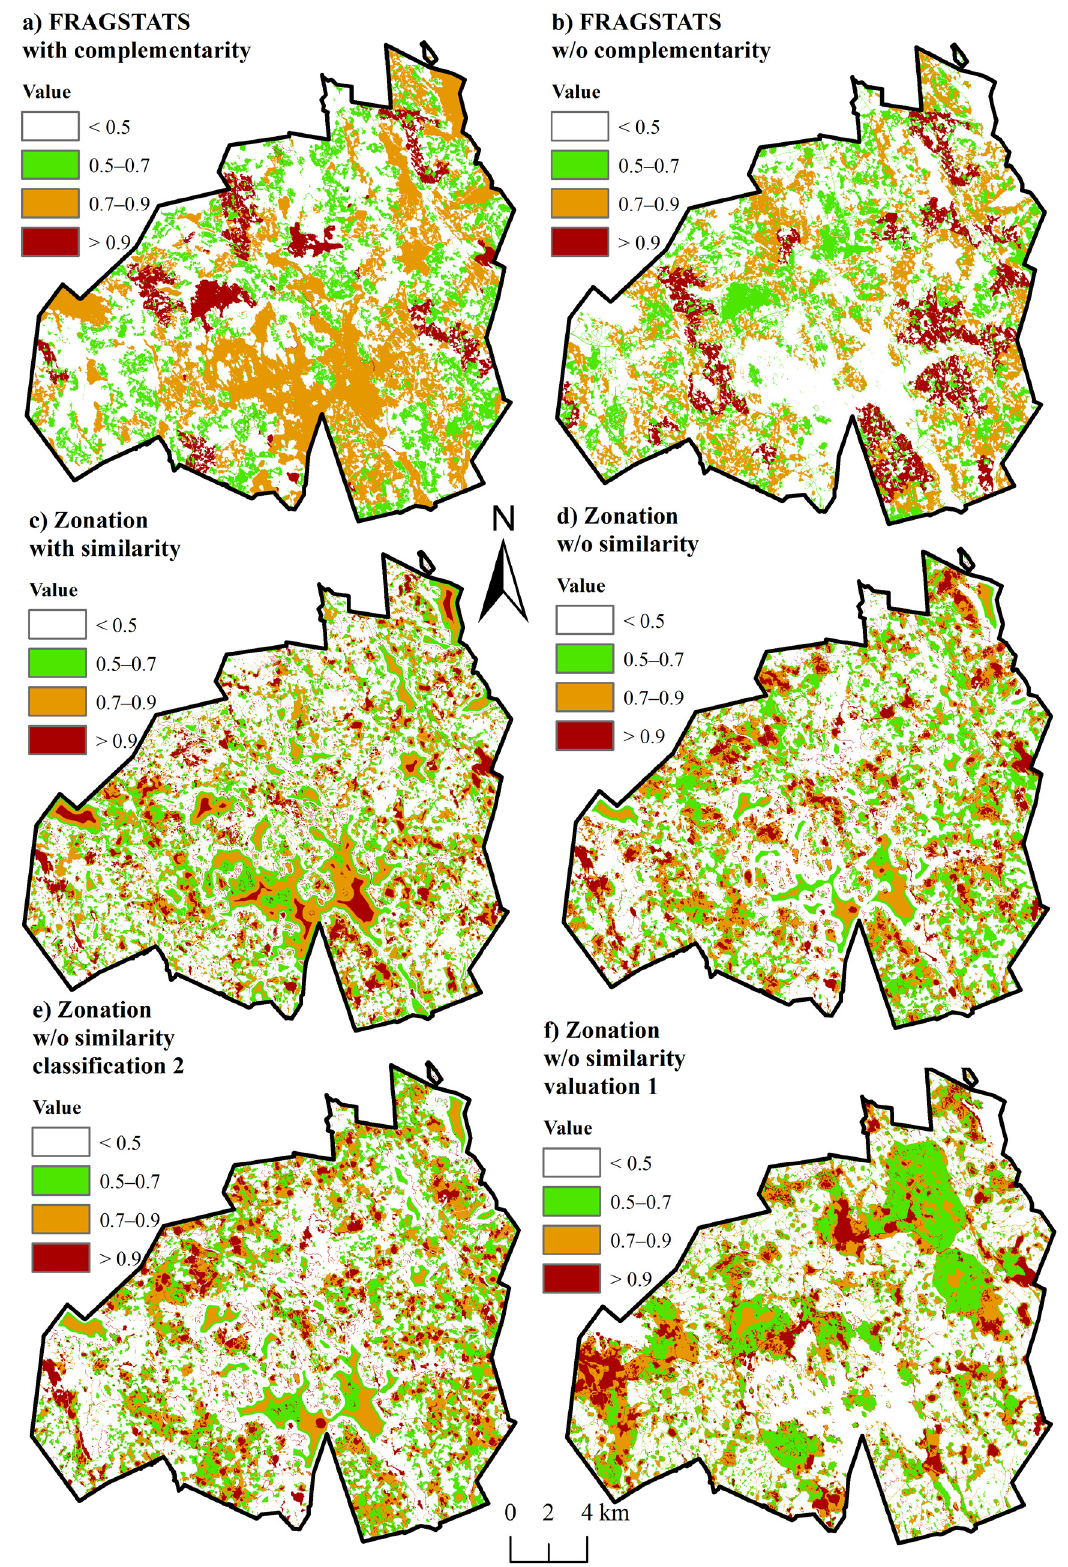
Figure 3: Different conservation value maps of the study area. Proportional value of the landscape is drawn. Areas in most valuable decile are drawn in black. Habitat type valuation alternative 6 (see Table A2) is used in a–e and alternative 1 in f. In a and c–e human habitats are given the lowest value. Classification alternative 1 (see Table A1) is used in a–d and f and alternative 2 in